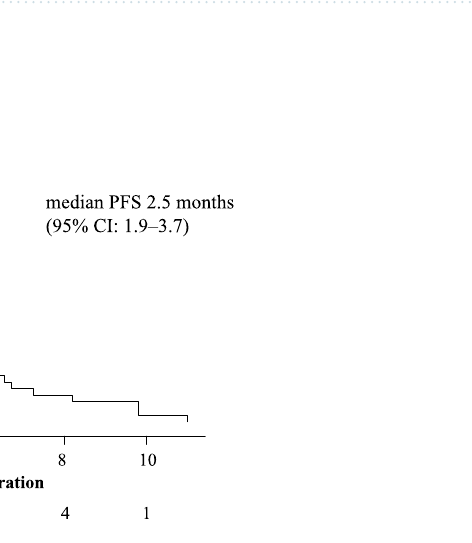
Figure 1. Swimmer plot of regorafenib dosing history. A summary of the weekly dosing history of each patient up to cycle 11 is shown. The symbol at the right end of each bar indicates the reason for treatment termination: + due to adverse event, * due to disease progression (N = 58).